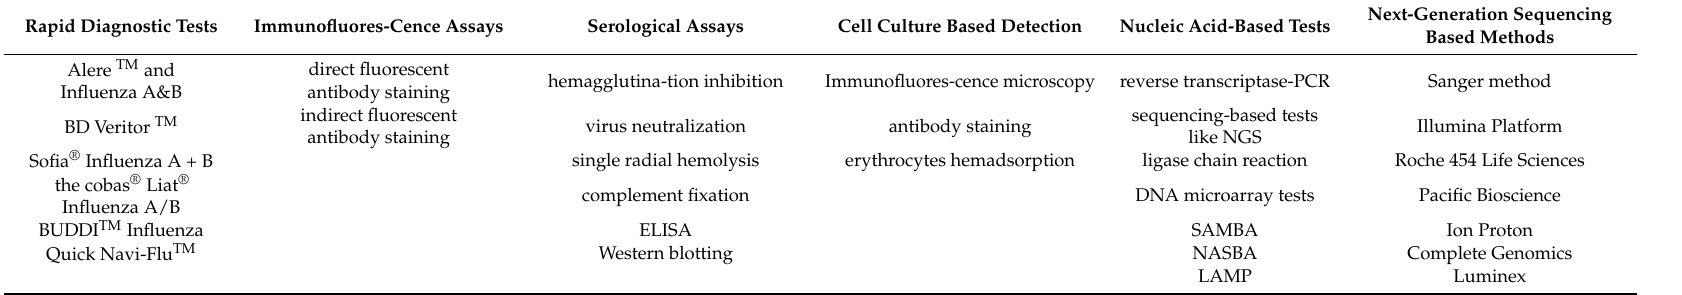
Table 1. Conventional methods of influenza virus